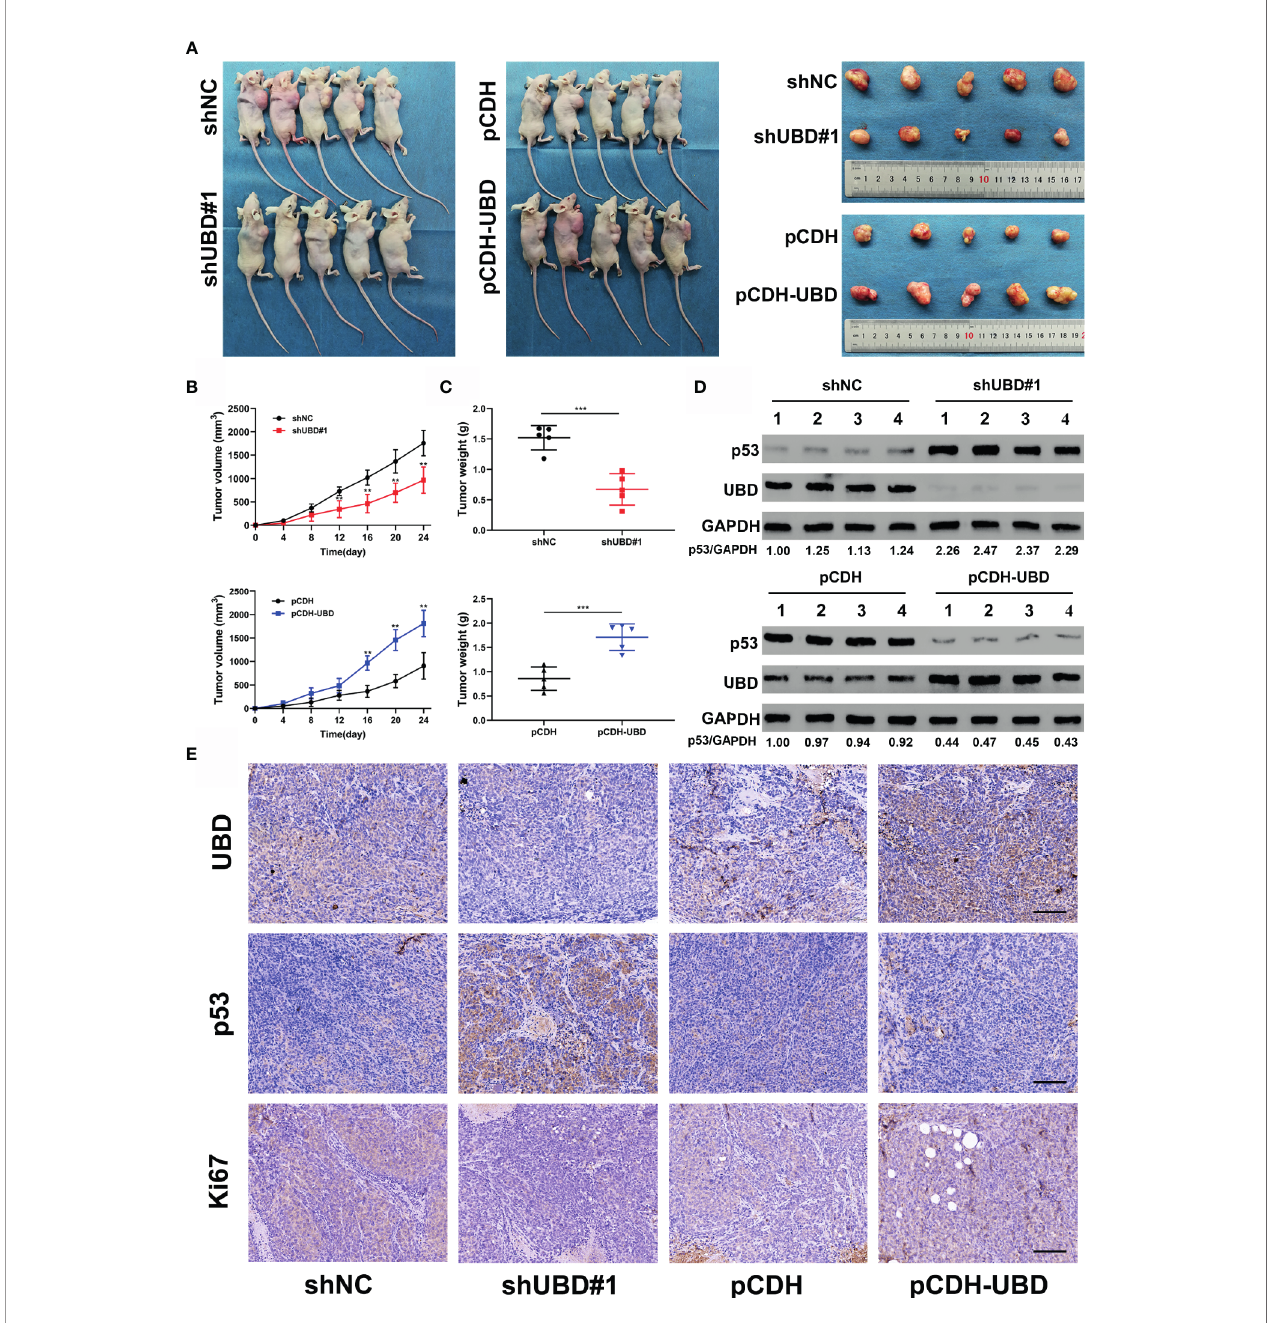
FIGURE 7 | UBD accelerates CRC cell growth by downregulating the expression of p53 in vivo. (A – C) HCT116 cells that stablely express shNC, shUBD#1, pCDH or pCDH-UBD were subcutaneously injected into the right armpits of nude mice ( fi ve mice per group). After 24 days of growth, the mice were euthanized, and the tumors were harvested, photographed (A) ; tumor volumes were measured periodically after injection and tumor growth curves were drawn (B) ; tumor weights were measured (C) (** p < 0.01; *** p < 0.001). (D) Protein levels of UBD and p53 in tumors from HCT116 injected cells in which UBD was stably downregulated or overexpressed (n=4 per group). GAPDH was used as an loading control. (E) IHC staining of UBD, p53 and Ki67 in xenograft tumor tissues (scale bar, 100 m